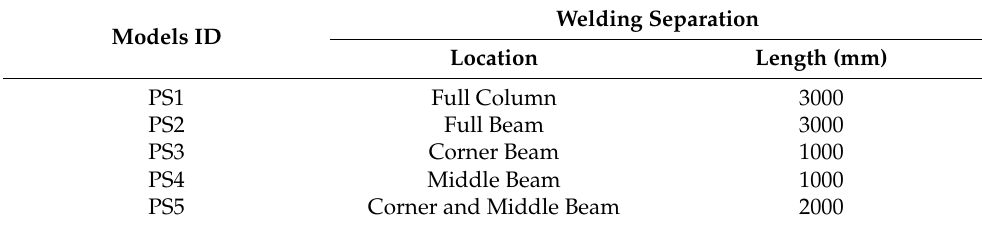
Table 1. Details of the parametric